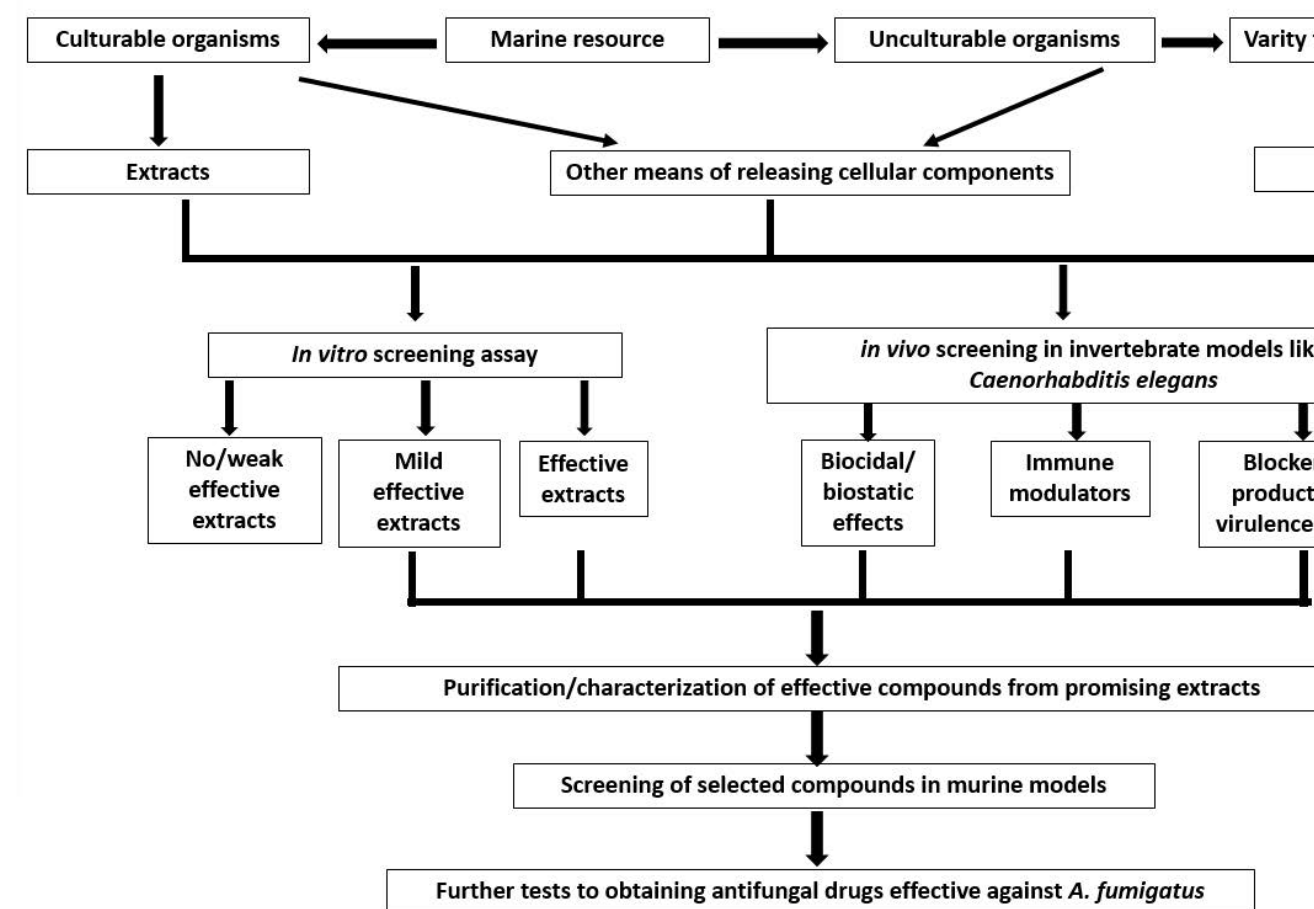
Figure 5. Flow chart of possible approaches to enhance the chances of discovering potent antifungal agents against A.